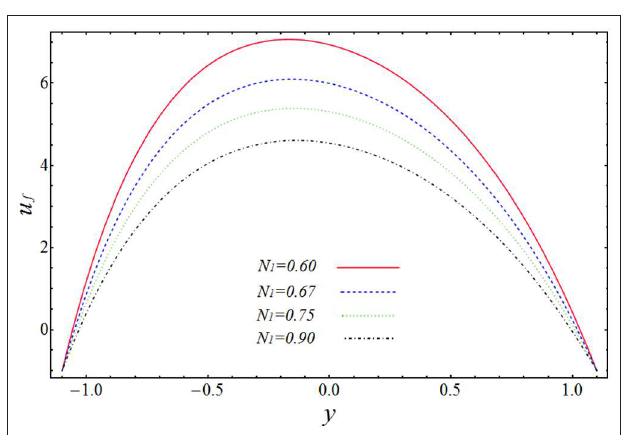
FIGURE 3 | Change of velocity u f for N 1 when Q = 1, x = 1, φ = 0.1, k 1 = 8, B = 0.02, A = 0.01, C = 0.12.